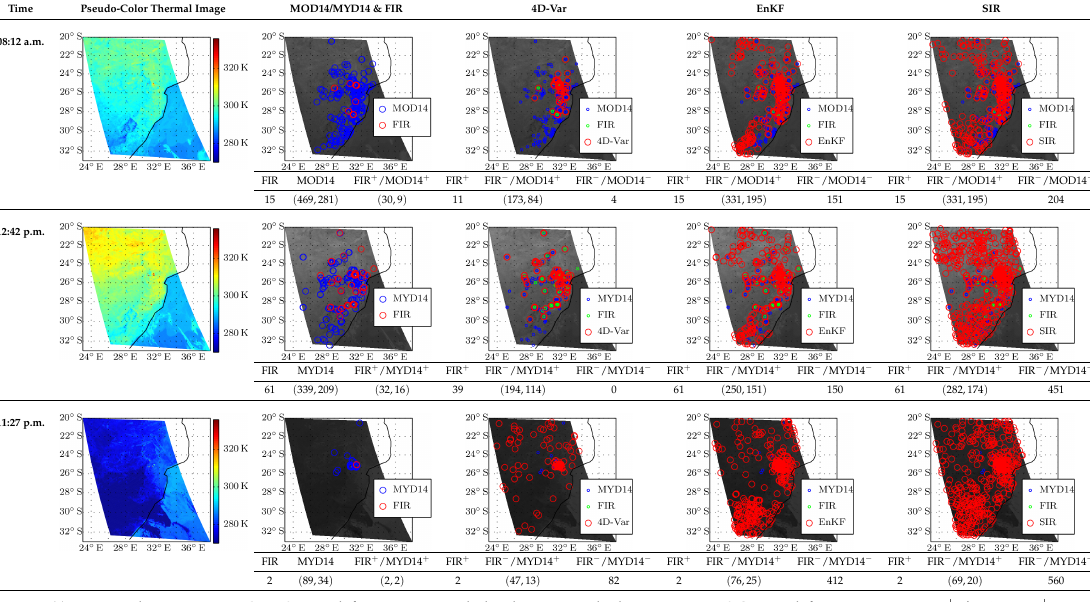
Table 5. Detection accuracy comparison against MODIS MOD14/MYD14 Fire products on 10 − 3.5